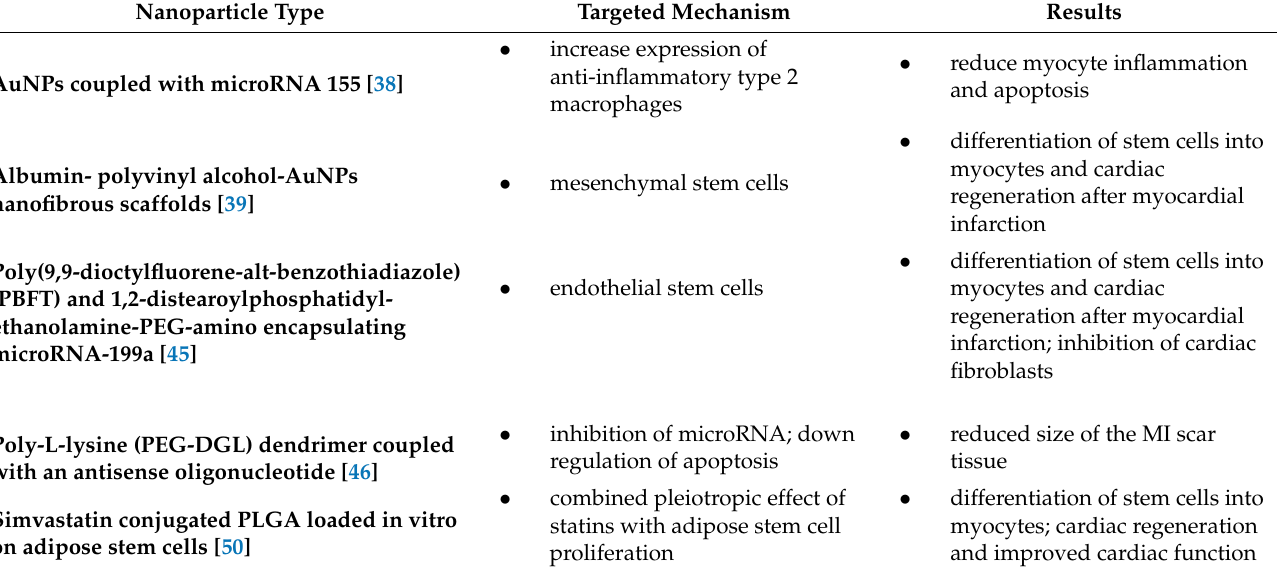
Table 2. Nanoparticles used for cardiac